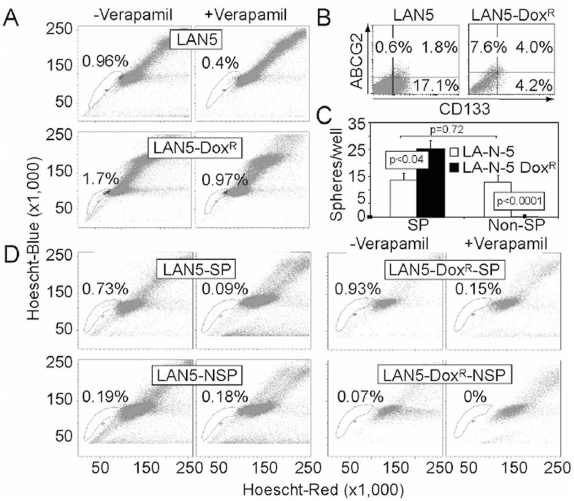
Side population analysis reveals asymmetric cell division of neuroblastoma cells.(A) Side population analysis using Hoechst 33342, +/−verapamil, of bulk LA-N-5 cells (LAN5) and LA-N-5 cells grown in doxorubicin (LAN5-doxR). (B) Analysis of ABCG2 and CD133 expression in LAN5 and LAN5-doxR cells. (C) Sphere-forming efficiency of sorted SP and non-SP (NSP) cells from LAN5 and LAN5-doxR cultures. (D) Sorted SP and NSP cells, from cultures of LAN5 and LAN5-doxR, were plated in serum containing media for 2 weeks and re-evaluated by side population, +/−verapamil. SP-derived cultures show regeneration of SP and NSP cells, while NSP-derived cultures showed only regeneration of NSP cells, not SP cells.